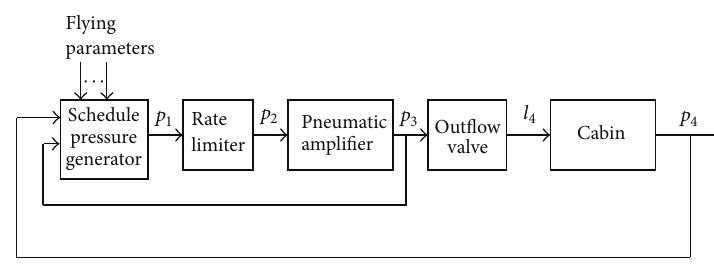
Figure 1: The diagram of cabin pressure regulating system.